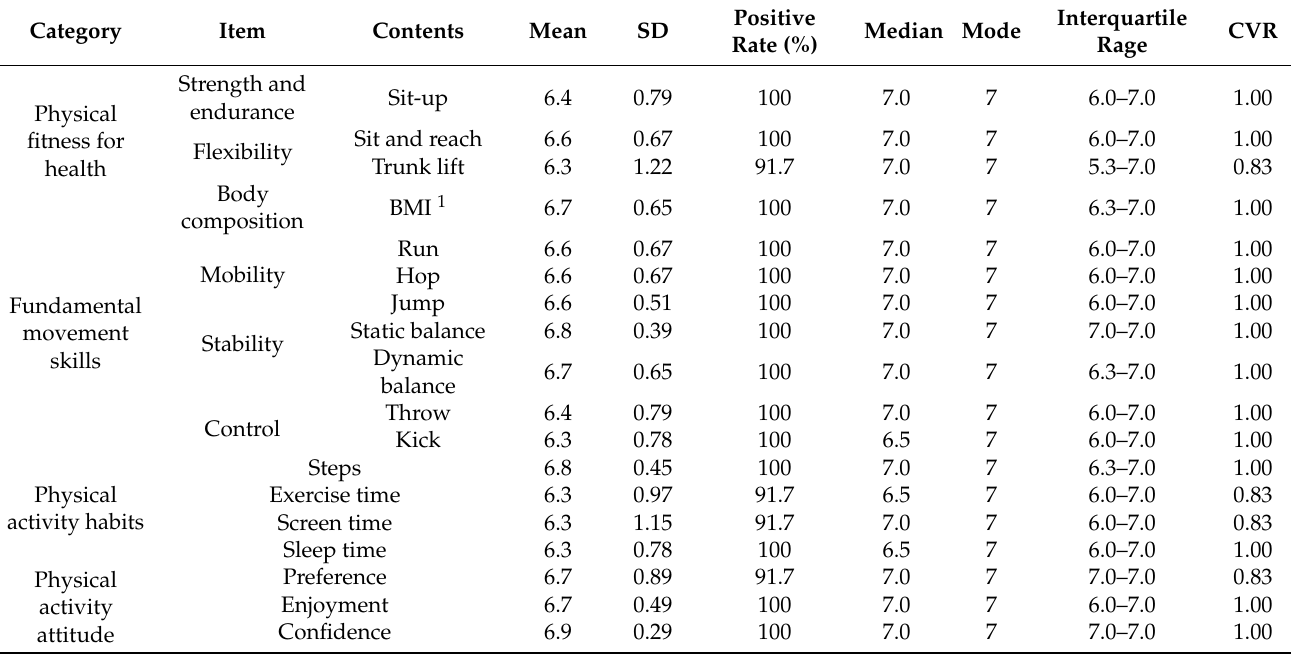
Table 2. Results of the 2nd Delphi